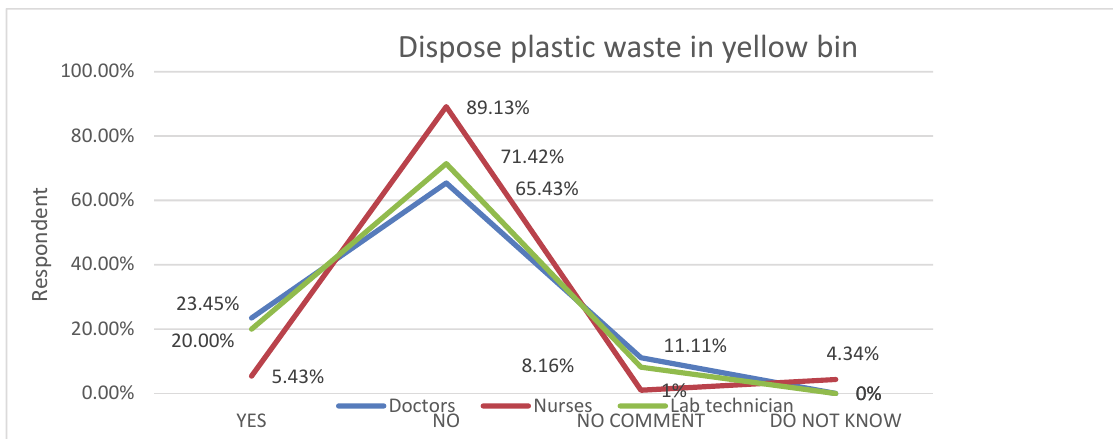
Fig. 13. Disposal of plastic waste in Yellow